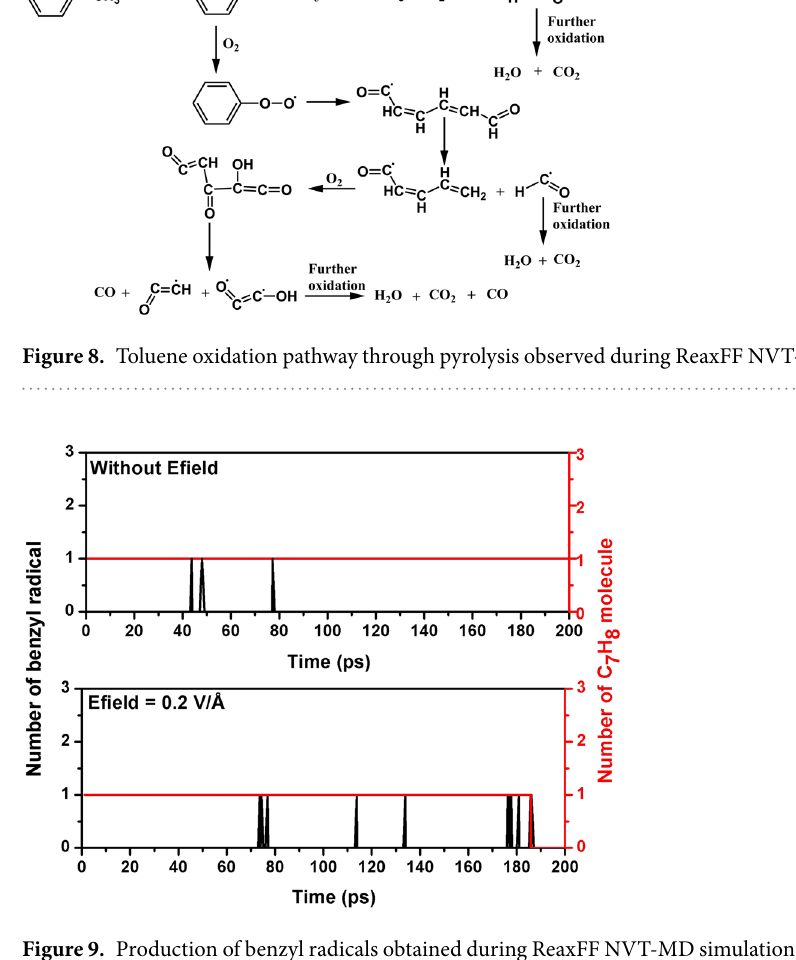
Figure 9. Production of benzyl radicals obtained during ReaxFF NVT-MD simulations with/without Efield = 0.2